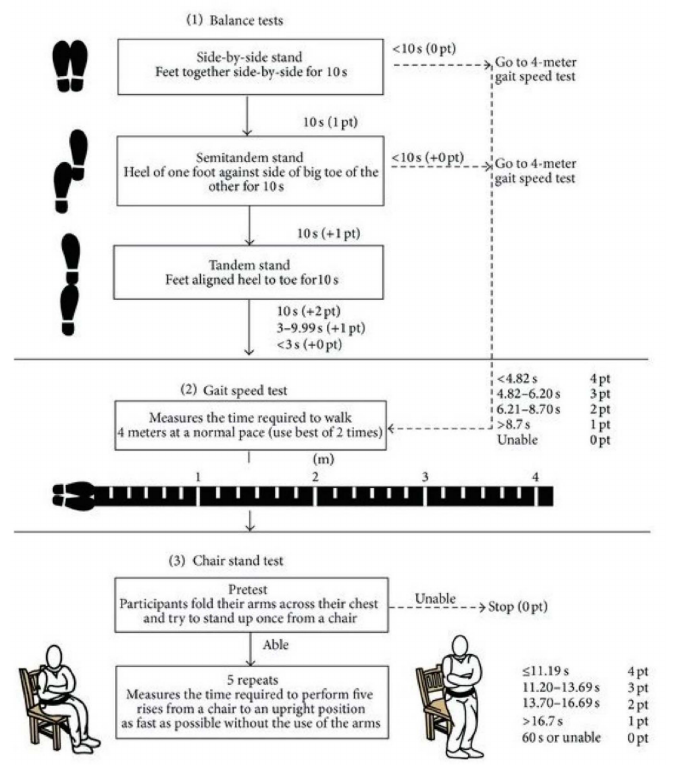
Figure 3. The Short Physical Performance Battery (SPPB) test. Reprinted with permission from Ref. [48]. Copyright 2021, copyright Riskowski, J.L. et